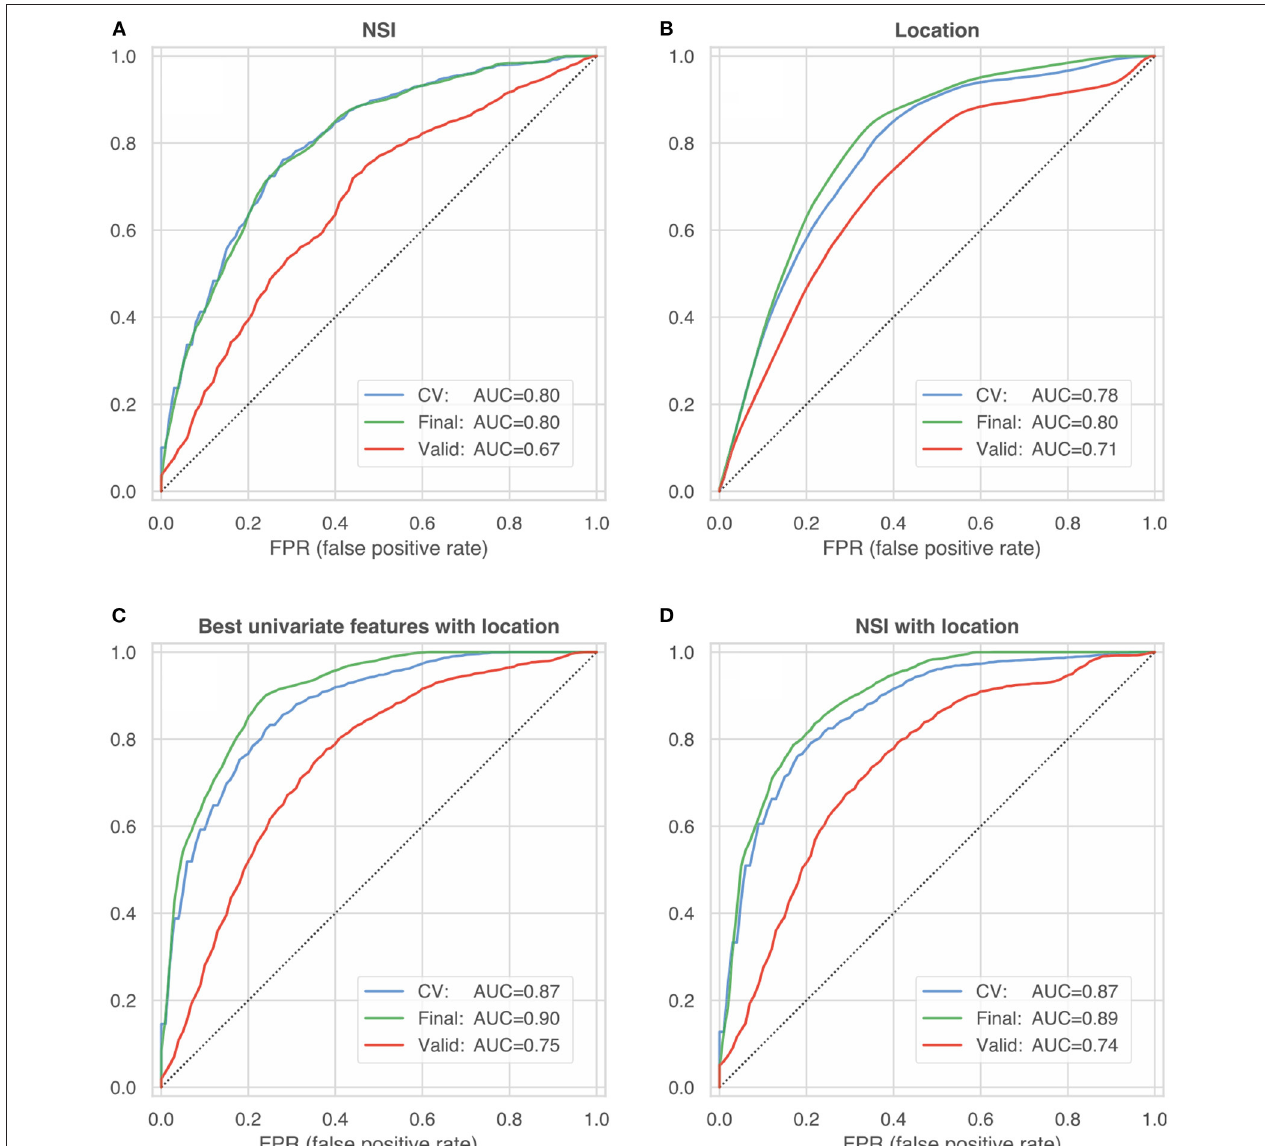
FIGURE 5 | ROC curves summarizing the internal and external validation of four different model configurations: (A) non-sphericity NSI (B) anatomical location (C) best univariate features according to Table 5 with location (D) NSI with location. The blue lines represent the internal model validation and constitute the mean of 100 ROC curves (computed on test-data folds) during cross-validated training (blue line, CV). The green and red lines characterize the performance of the final model trained on the entire HUG dataset, which was validated on 100 bootstrap samples of the HUG dataset (the training dataset, green lines) and the external validation datasets from the @neurIST and Aneurisk projects (red